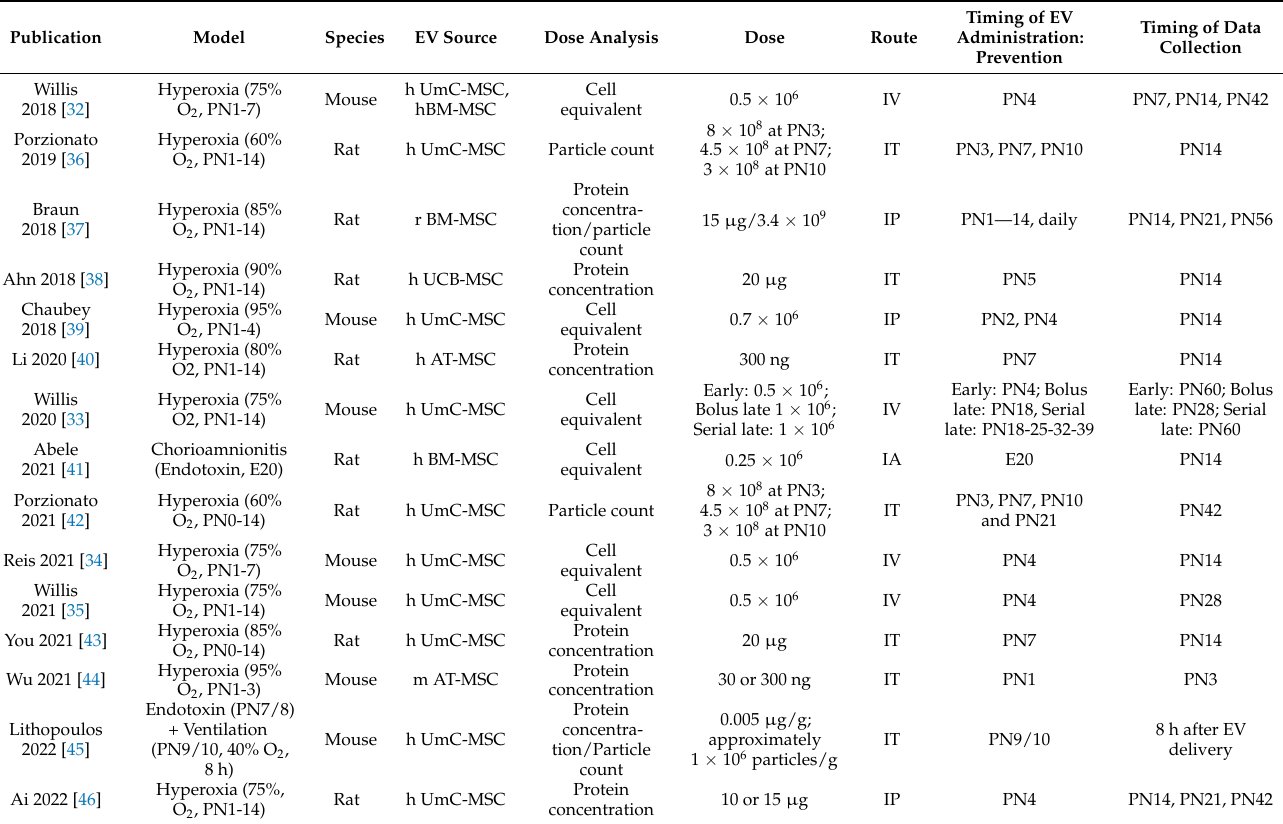
Table 1. In vivo experimental details of current MSC-derived EV-based preclinical studies in models of bronchopulmonary